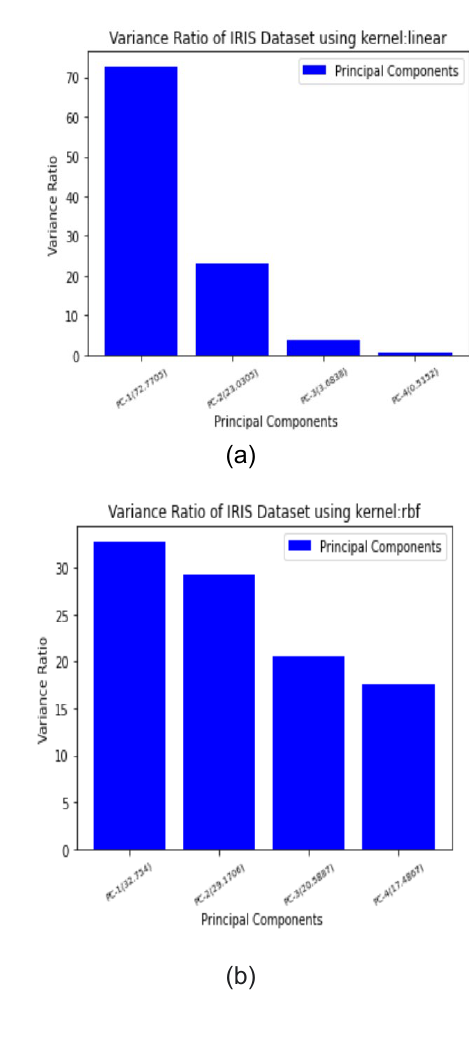
Figure (4) represents the performance of DIABETES data set based on the TSO-PCA algorithms. By projecting each data point on only the first few key components to obtain lower-dimensional data while retaining as much of the variance of the data as possible, PCA is widely used for dimension reduction. By using TSO-PCA, the dimension can be reduced by high to low and also arranged. Figure (4) represents the performance based on the TSO-PCA algorithms. It is utilized to reduce the high dimensional images in to the low dimension. The graphical representation of variance ratio of the existing method is given